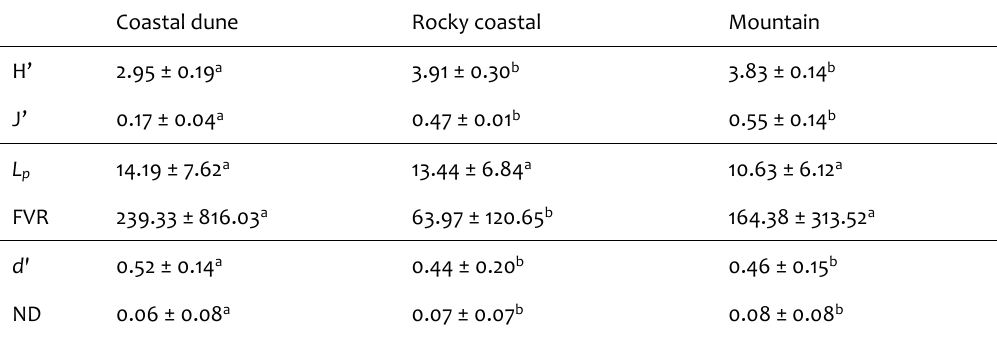
Table 1. Mean and standard deviation of each community for the six response variables studie d (Shannon diversity (H’); Pielou’s index (J’); Pollinator species richness per plant ( L p ); Flower visitation rate (FVR); Complementary specialisation index ( d’ ) and normalised pollination degree (ND) considering data recorded from two years (2009 and 2010) for each community studied: Son Bosc; coastal dune community, Cala Mesquida; rocky coastal community and Puig Major; mountain community. Communities showing significant differences (P < 0.05) are indicated by different